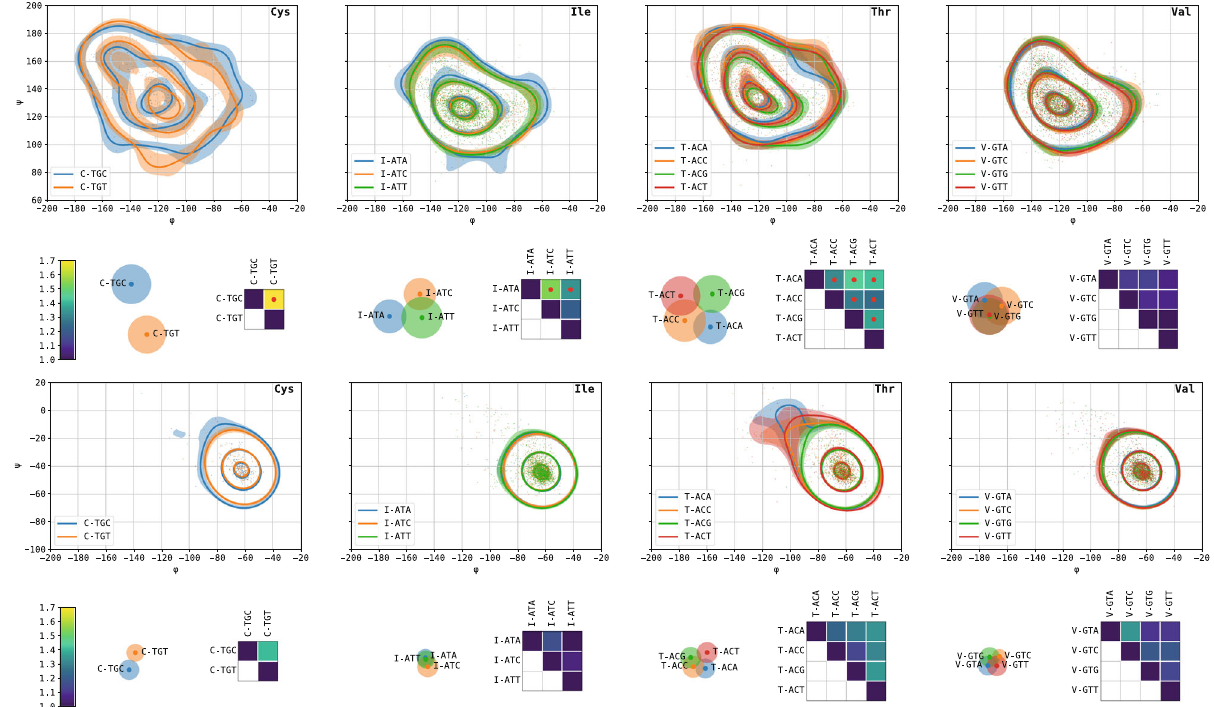
Fig. 3 Codon-speci fi c Ramachandran plots of select amino acids and distances between them. Shown left-to-right are cysteine, isoleucine, threonine, and valine. Contour plots depict the level lines containing 10, 50, and 90% of the probability mass. Shaded regions represent 10%-90% con fi dence intervals calculated on 1000 random bootstraps. The β - (top) and α - (bottom) modes are depicted. The matrices show L 1 distances between pairs of codon-speci fi c Ramachandran plots, normalized so that the self-distance is 1. Red dots indicate pairs with signi fi cantly different dihedral angle distributions based on their p value. The scatter plots visualizing the distance matrices were obtained by a variant of multidimensional scaling (MDS). Each point represents a codon; pairwise Euclidean distances between the points approximates the L 1 distance between the corresponding codons. Circles approximate the uncertainty radii. The more two circles overlap, the less distinguishable are the corresponding codon-speci fi c Ramachandran plots.